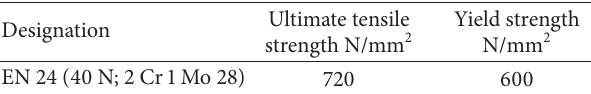
Table 6: Selection of material for coupler shaft.